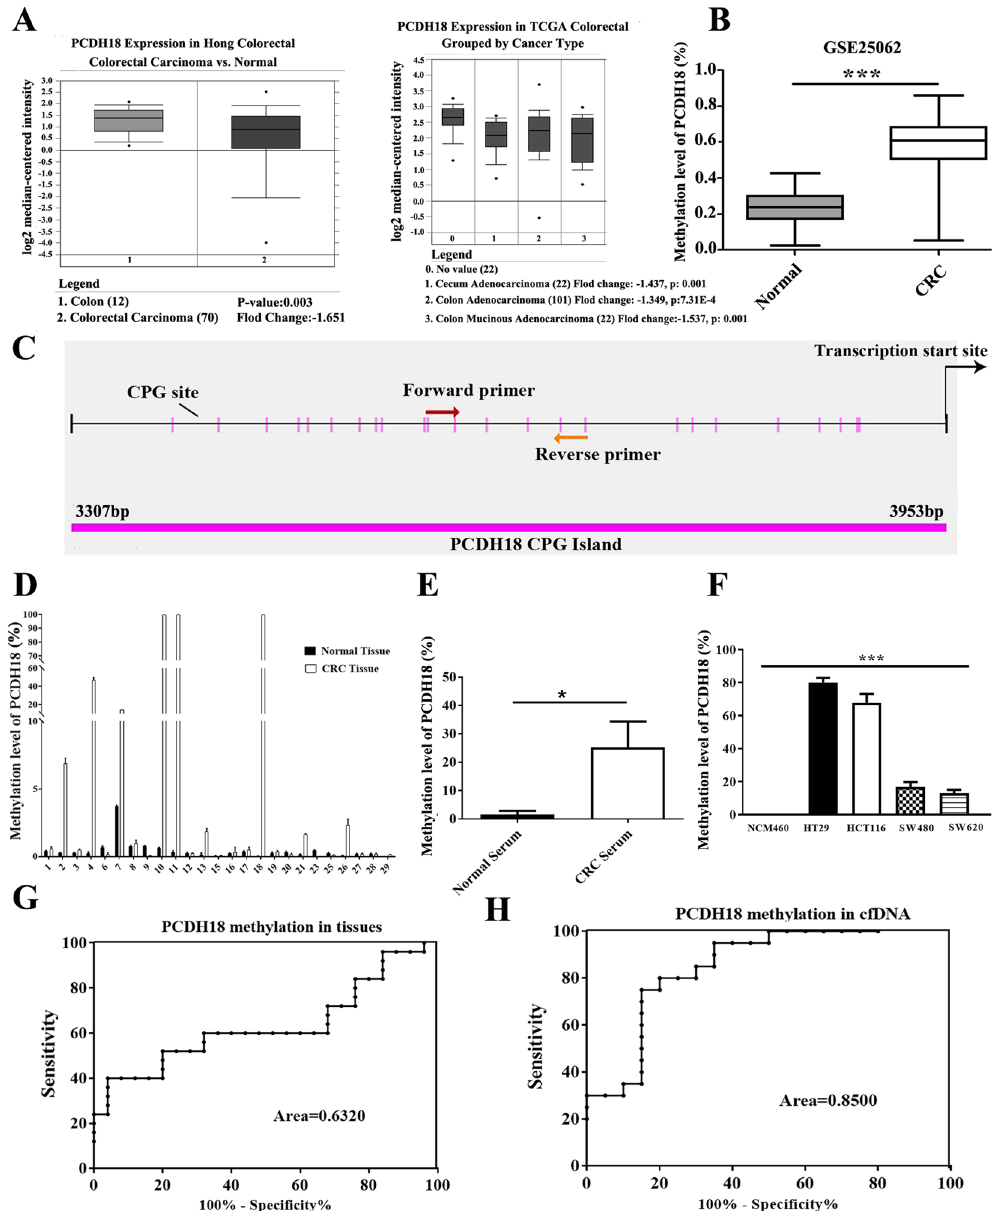
Figure 1. ( A ) Expression level of PCDH18 was significantly downregulated in colorectal cancer (CRC) tissues compared to normal controls in Hong Colorectal dataset and The Cancer Genome Altas expression array dataset from Oncomine. ( B ) A significant difference of PCDH18 methylation status was observed between 125 CRC tissues and 29 adjacent normal tissues in GSE25062 dataset. ( C ) Schematic structure of the PCDH18 promoter CpG islands, CpG sites (short vertical lines) and methylation specific PCR (MSP) region indicated (from forward primer to reverse primer). The transcription start site was showed by a curved arrow. ( D ) Methylation percentage of PCDH18 in 29 paired CRC tissues and normal tissues was detected by MSP. ( E ) Methylation percentage of PCDH18 in plasma from 20 CRC cases and 20 healthy subjects was examined by MSP. ( F ) Methylation percentage of PCDH18 in CRC cell lines (HT29, HCT116, SW480 and SW620) and normal colonic NCM460 cells were detected by MSP. ( G ) Receiver operating characteristic (ROC) curves showed the performance of PCDH18 methylation status from CRC tissues in predicting CRC. ( H ) ROC curves showed the performance of PCDH18 methylation status from CRC plasma in predicting CRC. Sensitivity means true-positive rate. Specificity means false-positive rate. Results were shown with means ± SD. * p < 0.05, *** p <